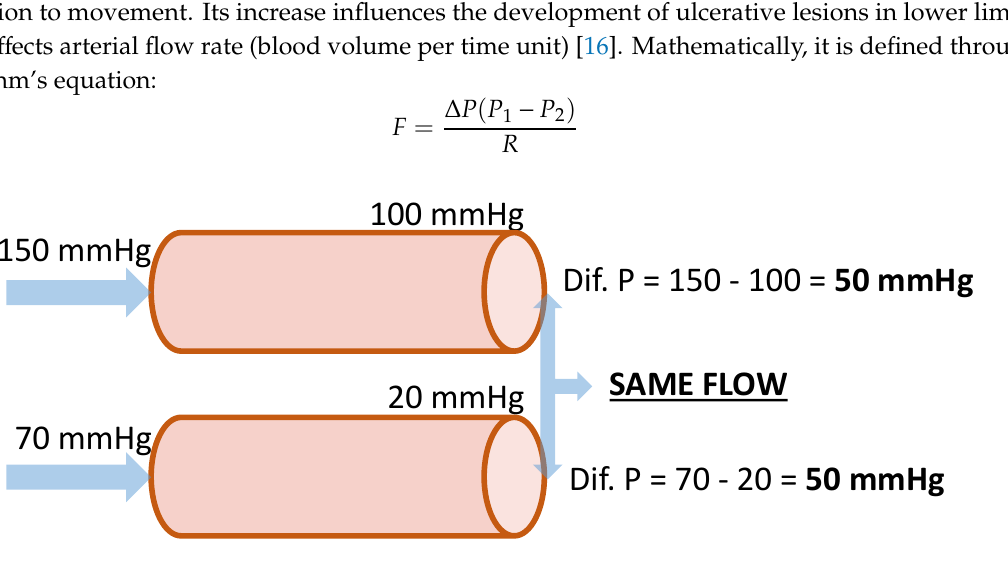
Figure 2. Gradient of a fluid